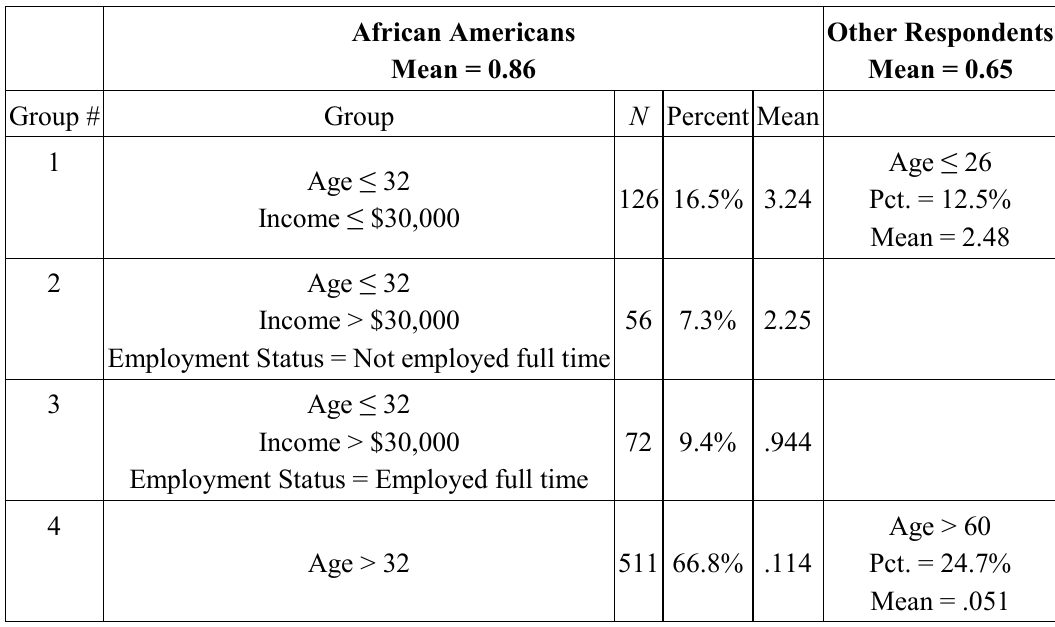
Table 6. CART analysis for social